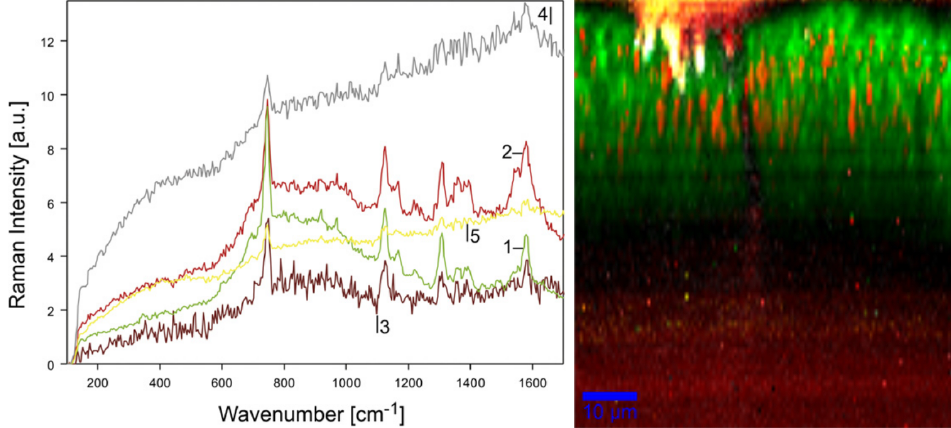
Figure 9. (Resonant) Raman spectra ( left ) and outer layer of a biofilm granule ( right ) showing a dense multilayer of microcolonies crossed centrally by a vertical canal. The color of the spectra also provide the color-code of the image; bacterial seed fingerprint type-I identified as nitrosomonas communis (1, green), bacterial seed fingerprint type-II, probably nitrosomonas europaea , (2, red), and cytochrome c spectrum 80 µ m below the surface (3, brown) with too low S/N to be assigned to a specific species. The spectra 4 and 5 denote weak and weakest autofluorescence spectra depicted in the image as white and yellow areas (reproduced with permission from